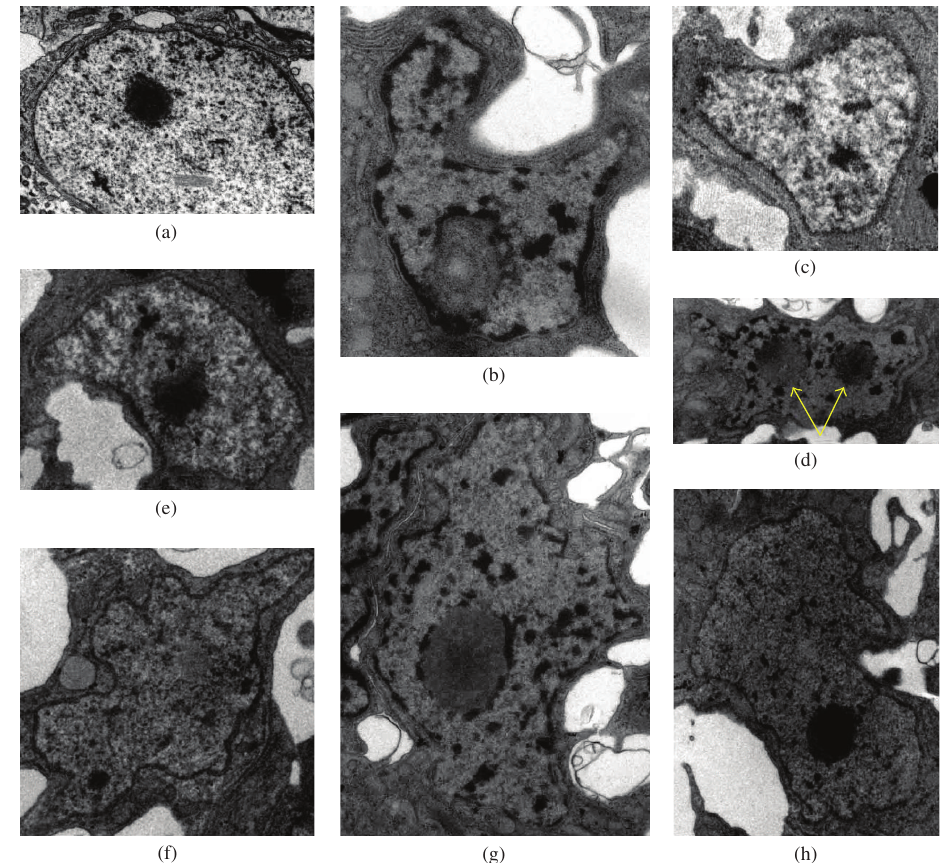
FIGURE 3: Ultrastructural changes in the hepatopancreas of B. aeruginosa exposed to the suspension of M. aeruginosa and mixed algae, respectively. (a) Nucleus of control snail, 12000x. (b) and (c) The deformation and fading of nucleus in the mixed group at 5 days and 15 days postexposure, respectively, 30000x and 20000x. (d) The binucleate cell (yellow arrow), 12000x. (e) The condensation of chromatin in the cyanobacterial group at 5 days postexposure, 20000x. (f) The fading of nucleus in the cyanobacterial group at 10 days postexposure, 20000x. (g) The recovery of nucleus in the mixed group after 15 days of detoxification, 22000x. (h) The recovery of nucleus at the end of the experiment in the cyanobacterial group,